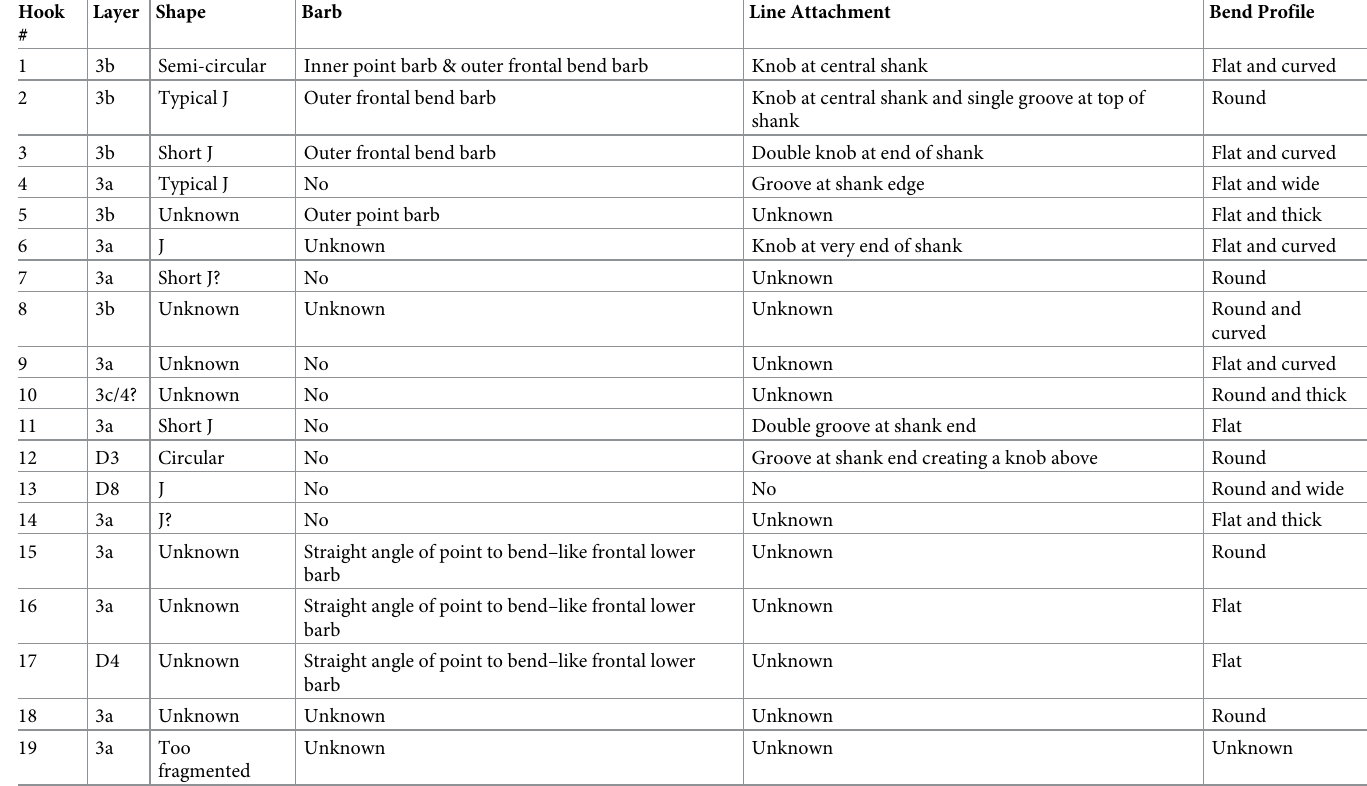
Table 1. JRD fish hook inventory including the presence and absence of hook features. The JRD hooks are reposited at the Prehistory Laboratory, Tel Hai College, Israel. The 3D fishhook models are available (wrl format) at https://doi.org/10.7910/DVN/VTKRQW.